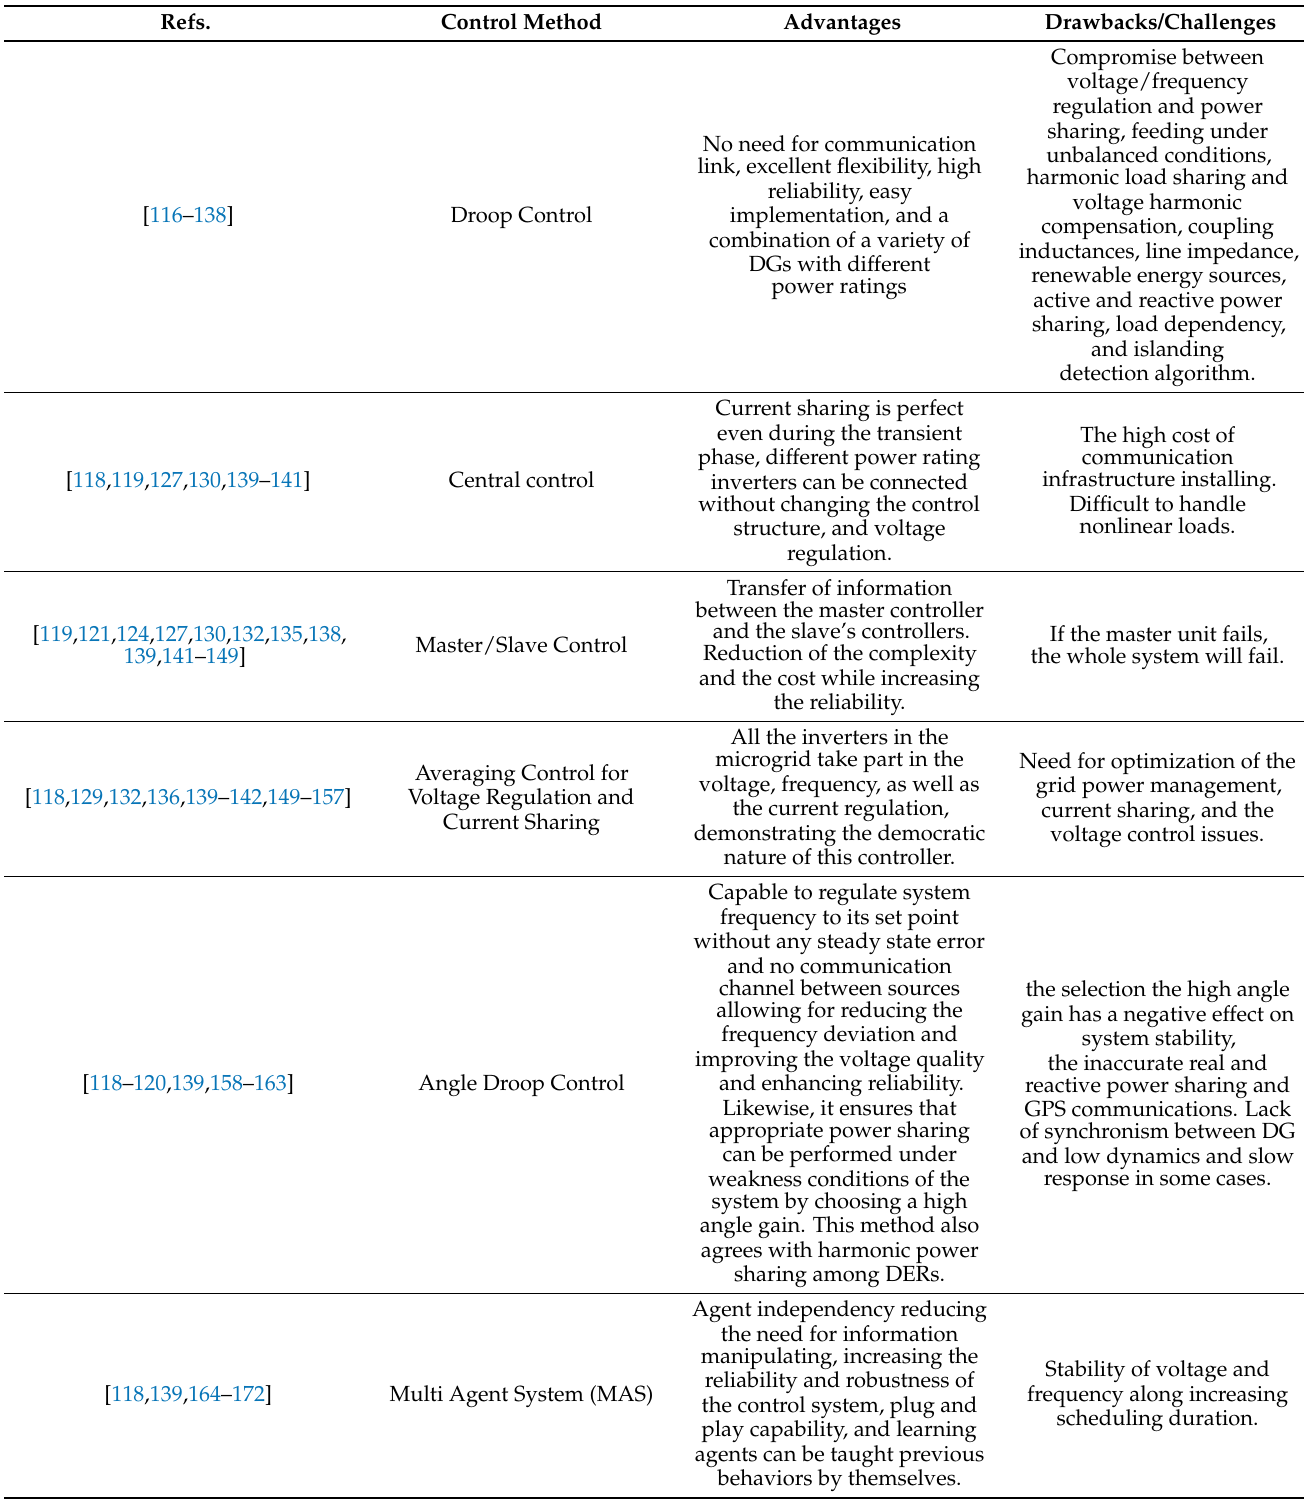
Table 6. Analysis of contributions based on grid-following inverter MG control.